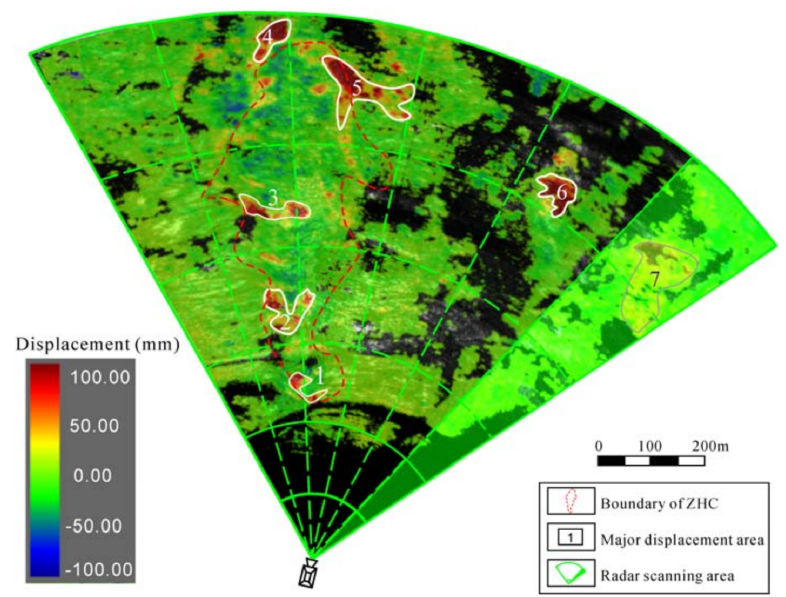
Figure 12. Cumulative deformation map produced by the MDSR-LSAR from 17:45, 21 August to 13:19, 22 August.